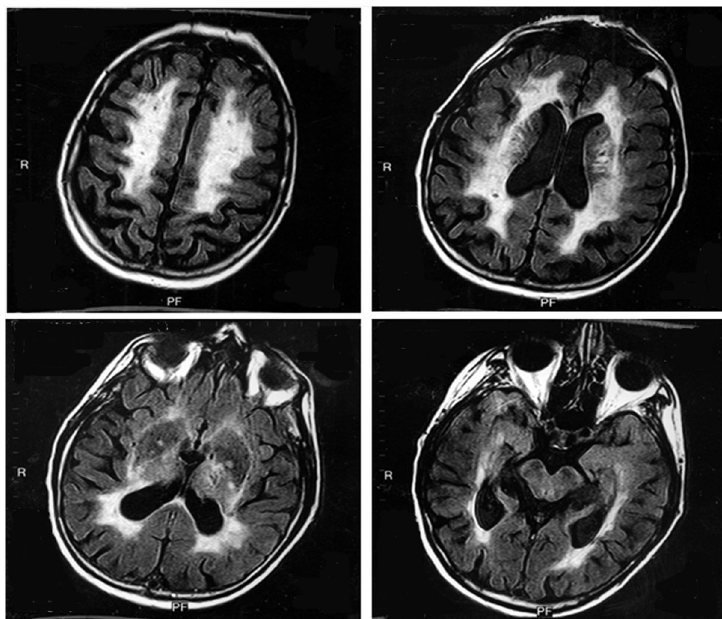
Figure 1. Bilateral small chronic infarcts and patchy and confluent areas of leukoaraiosis seen on fluid attenuated inversion recovery (FLAIR) MRI on patient with NOTCH3 p.R558C mutation. doi: